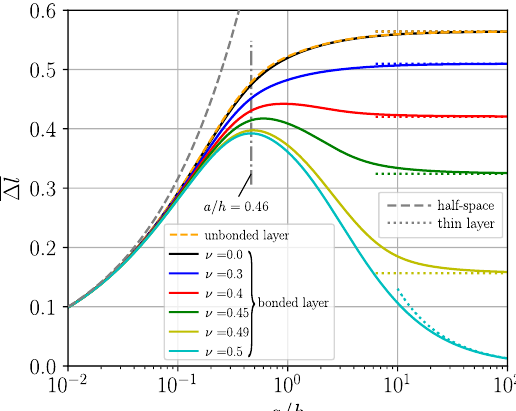
Figure 8. Normalized maximum spring elongation according to Equation (42) in terms of the confinement ratio a / h